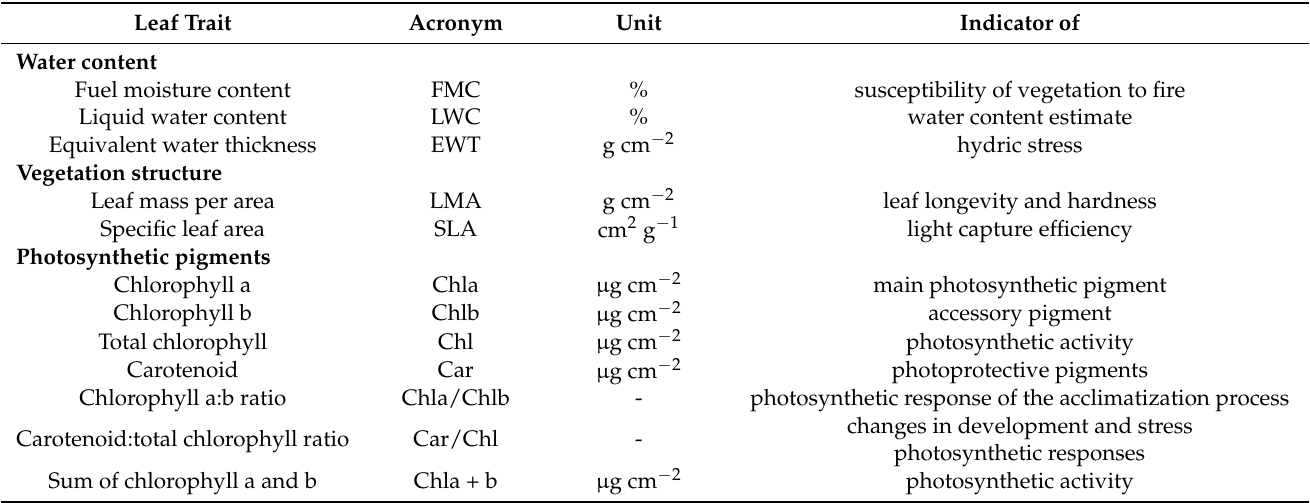
Table 1. Synthesis of traits and functions recorded for plant species at Quarta Colonia State Park during the 2020 field